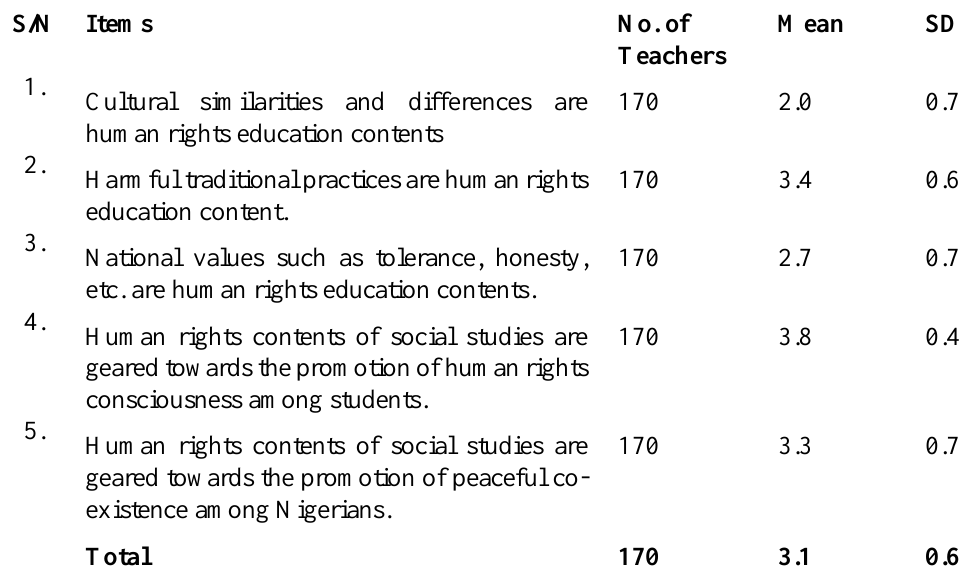
Table 2: Mean and SD statistics of teachers’ awareness of Basic Education Social Studies Curricular HRE contents and purpose